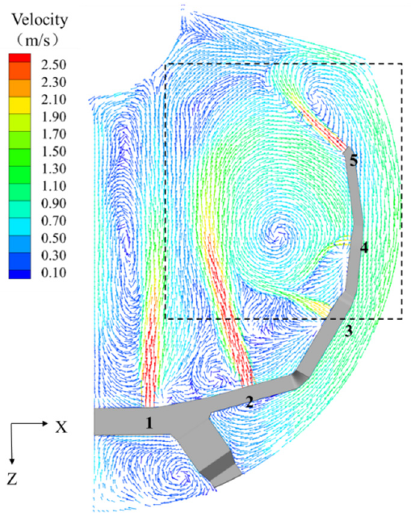
Figure 7. Velocity vector diagram at the section of y = 0.71 m under case A (dashed box represents the vortex area to be zoomed in Figure 8).